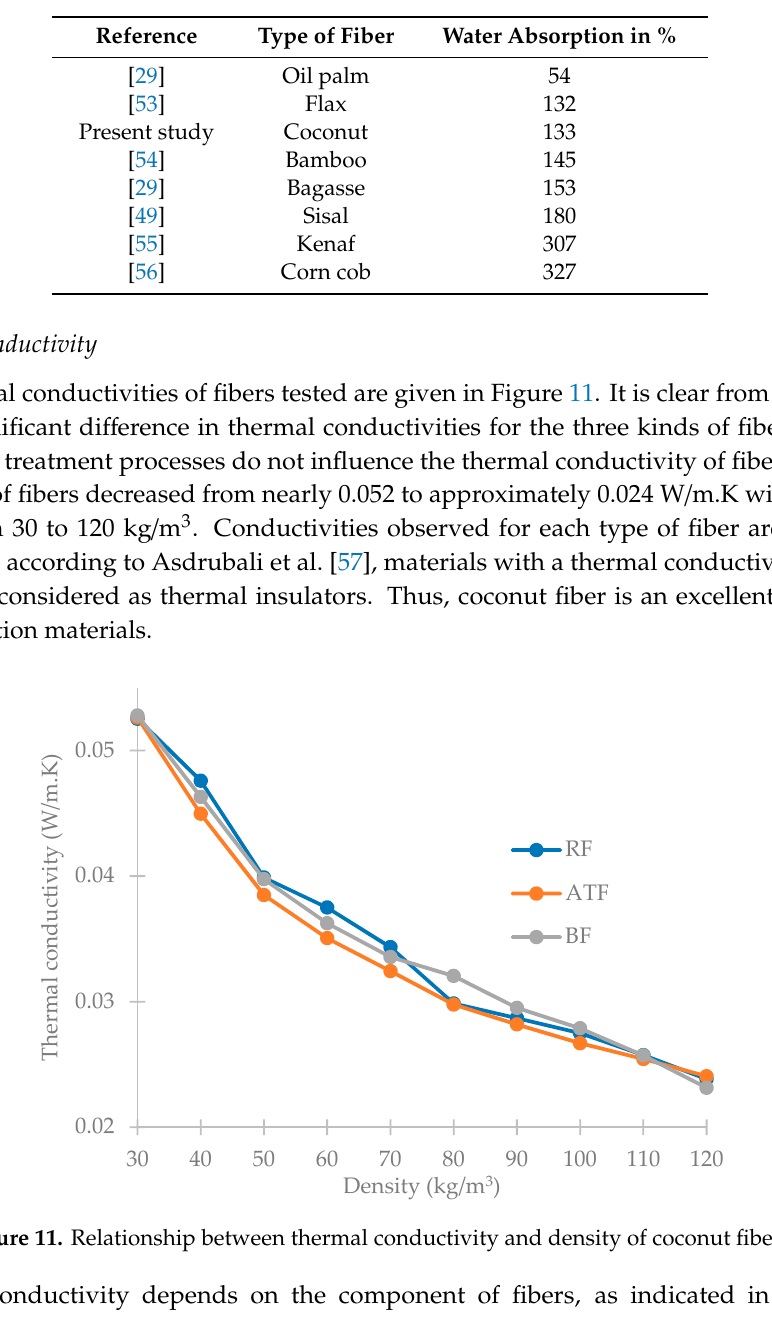
Table 3. Water absorption capacity of some plant fibers from the literature.